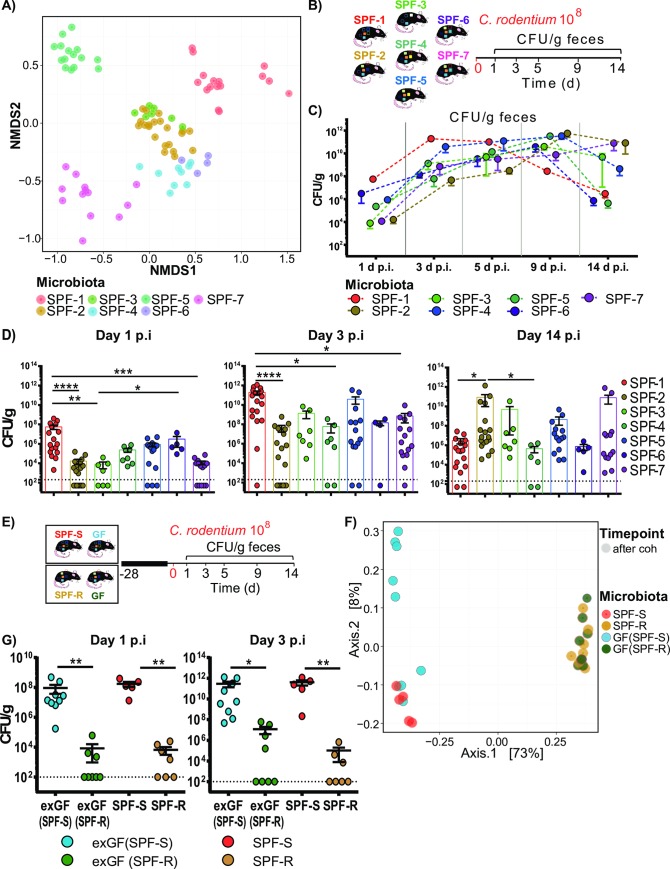
Isogenic mouse lines feature distinct microbiota compositions and varying disease kinetics after Citrobacter rodentium infection.(A) Fecal bacterial microbiota composition of different specific pathogen free (SPF) mouse lines including SPF-1/SPF-S (n = 17), SPF-2/SPF-R (n = 18), SPF-3 (n = 7), SPF-4 (n = 9), SPF-5 (n = 15), SPF-6 (n = 4) and SPF-7 (n = 12) were evaluated using 16S rRNA gene sequencing. β-diversity was analyzed using Bray-Curtis dissimilarity matrix and non-metric multidimensional scaling (NMDS). (B) Mice with different microbiota settings were orally infected with 108 CFU C. rodentium. (C) CFU of C. rodentium was determined in the feces of each mouse line at day 1, 3, 5, 9 and 14 post infection (p.i.). (D) Fecal colonization of each individual mouse is indicated after day 1, 3 and 14 p.i. Dashed line indicates detection limit. Results represent one representative experiment with n = 4–17 mice/group as mean ± SEM. P values indicated represent a nonparametric Kruskal-Wallis test with multiple comparisons (one-way ANOVA). *p<0.05, **p<0.01, ***p<0.001, ****p<0.0001. (E) C57BL6/N germ-free mice (GF) were cohoused with SPF-S and SPF-R mice for 4 weeks and then infected with C. rodentium. (F) Fecal microbiota was analyzed using 16S rRNA gene sequencing before and after the end of cohousing. β-diversity was analyzed using a principal coordinates analysis (PCoA) plot. (G) C. rodentium CFUs in feces of individual mice of each mouse line are displayed on day 1 and 3 p.i. Dashed lines indicate the limit of detection. Results represent one out of three representative experiments with n = 5–9 mice/group as mean ± SEM. P values indicated represent a Mann-Whitney U test comparison between group exGF(SPF-S) and exGF(SPF-R) as well as SPF-S and SPF-R. *p<0.05, **p<0.01, ***p<0.001, ****p<0.0001.